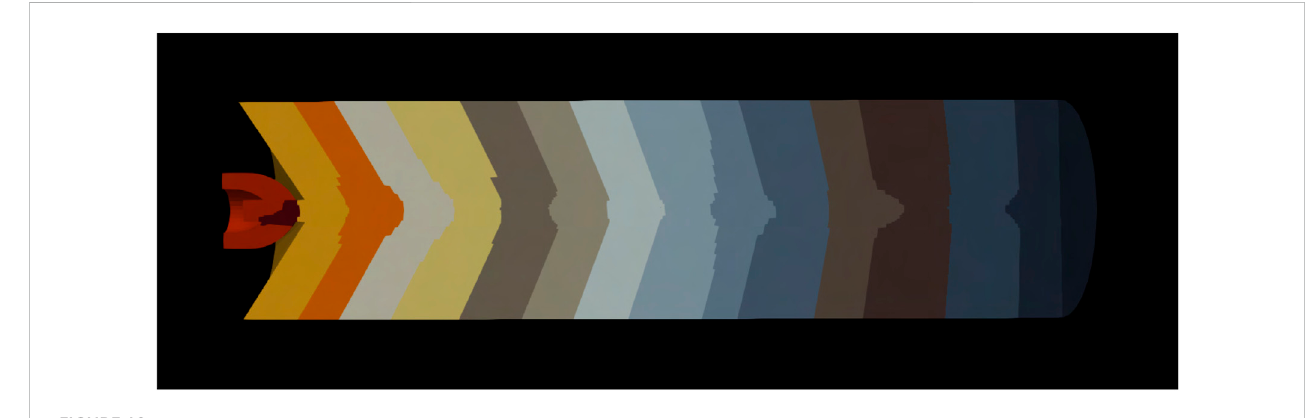
FIGURE 10 Computational geometry section distributed across different processors according to the Scotch domain decomposition strategy.